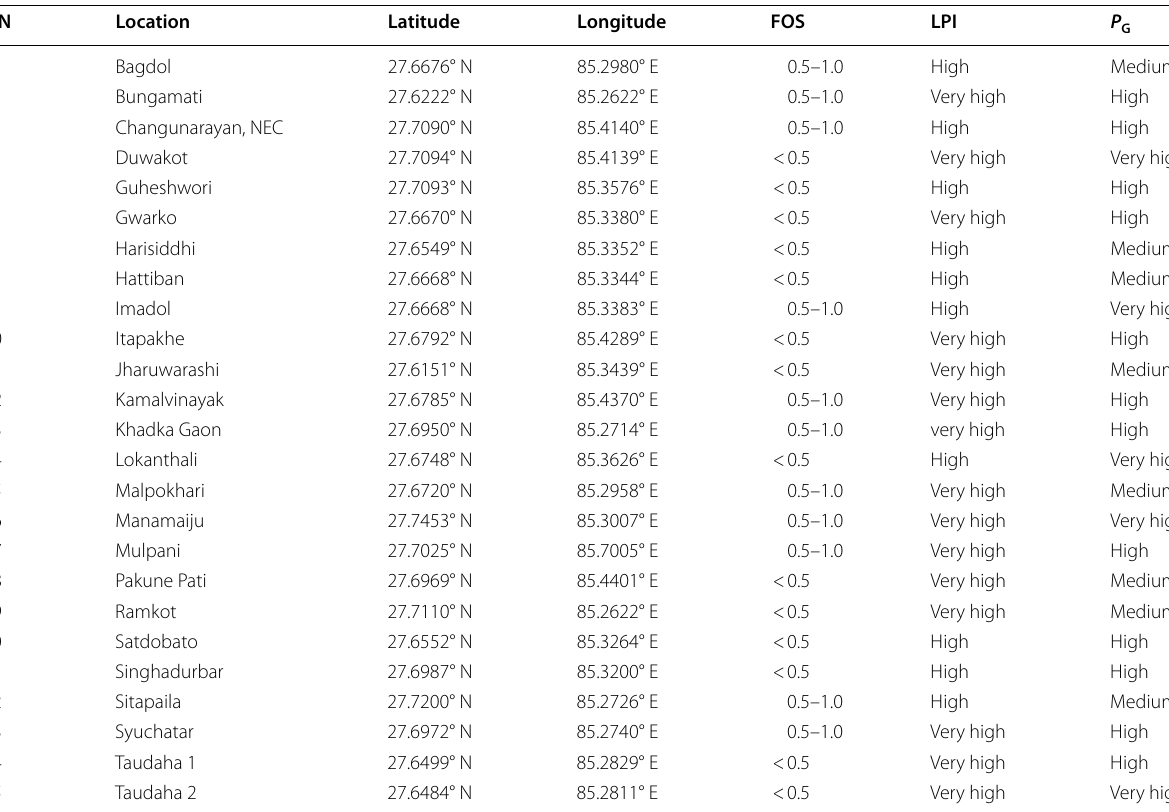
at liquefaction observed sites during the 2015 Gorkha Earthquake G